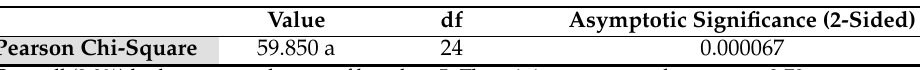
Table 27. Chi-square tests.